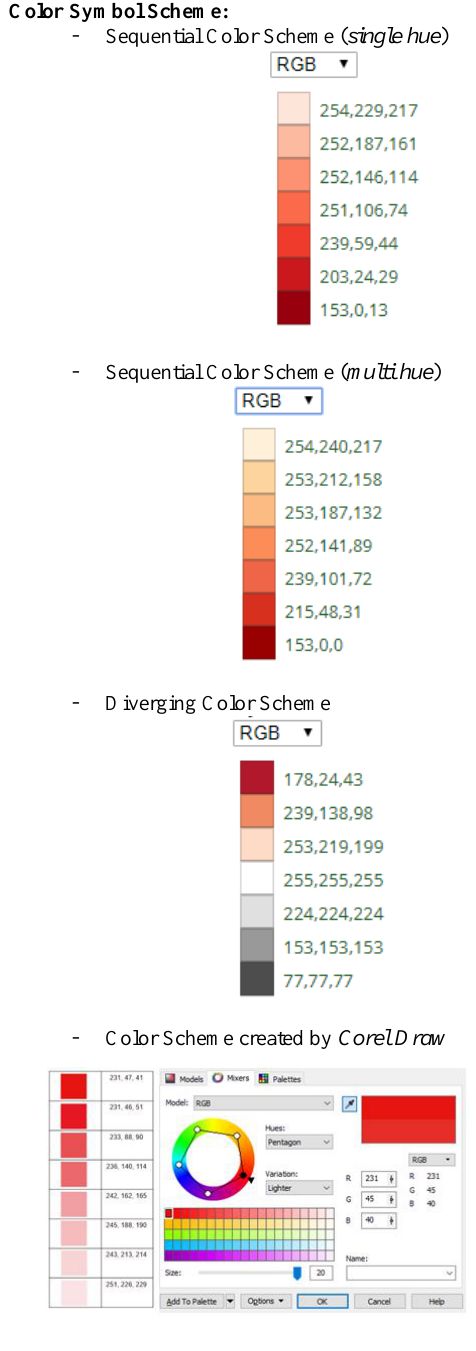
(Classification Method Effectiveness Test)